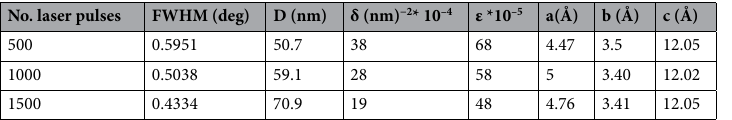
Table 1. Crystallite size, strain, dislocation density and lattice constants of B4C NPs along (021) plane.